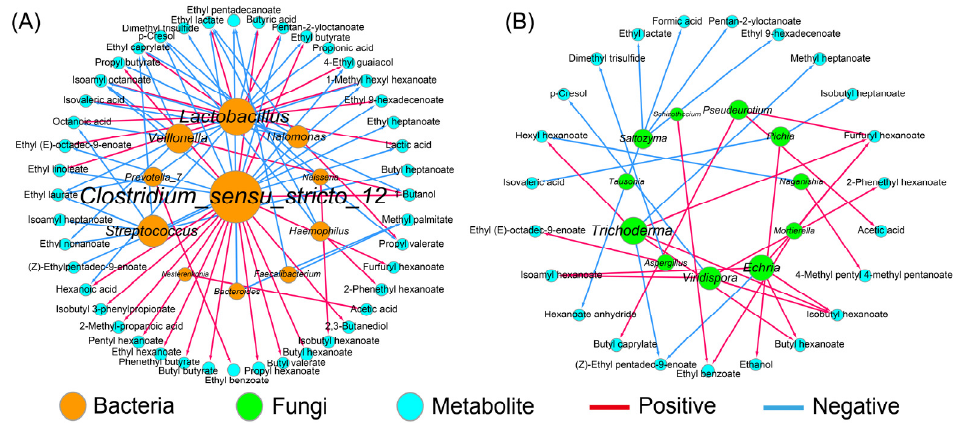
Figure 4. The correlation analysis between dominant microorganisms and metabolites in artificial pit mud. All links represent the significant correlation based on Spearman’s correlation coefficient (| ρ | > 0.7 and p < 0.05). The size of each microorganism node is proportional to its degree of connection with the volatiles; ( A ) bacteria; ( B ) fungi.